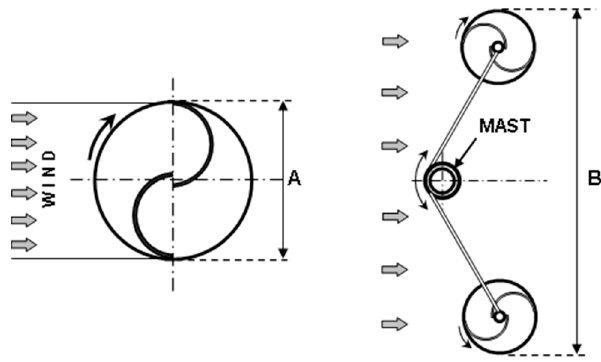
Figure 7. Unfolded system for maximum wind capture.